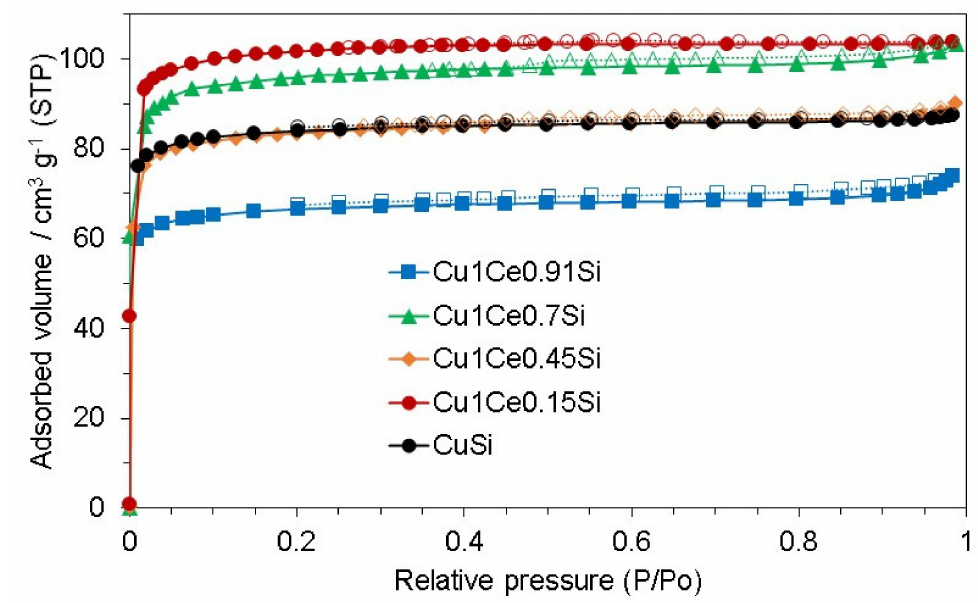
Figure 4. N 2 -physisorption isotherms of the combustion-synthesized composites. Table 2. Composition and textural properties of synthesized composite